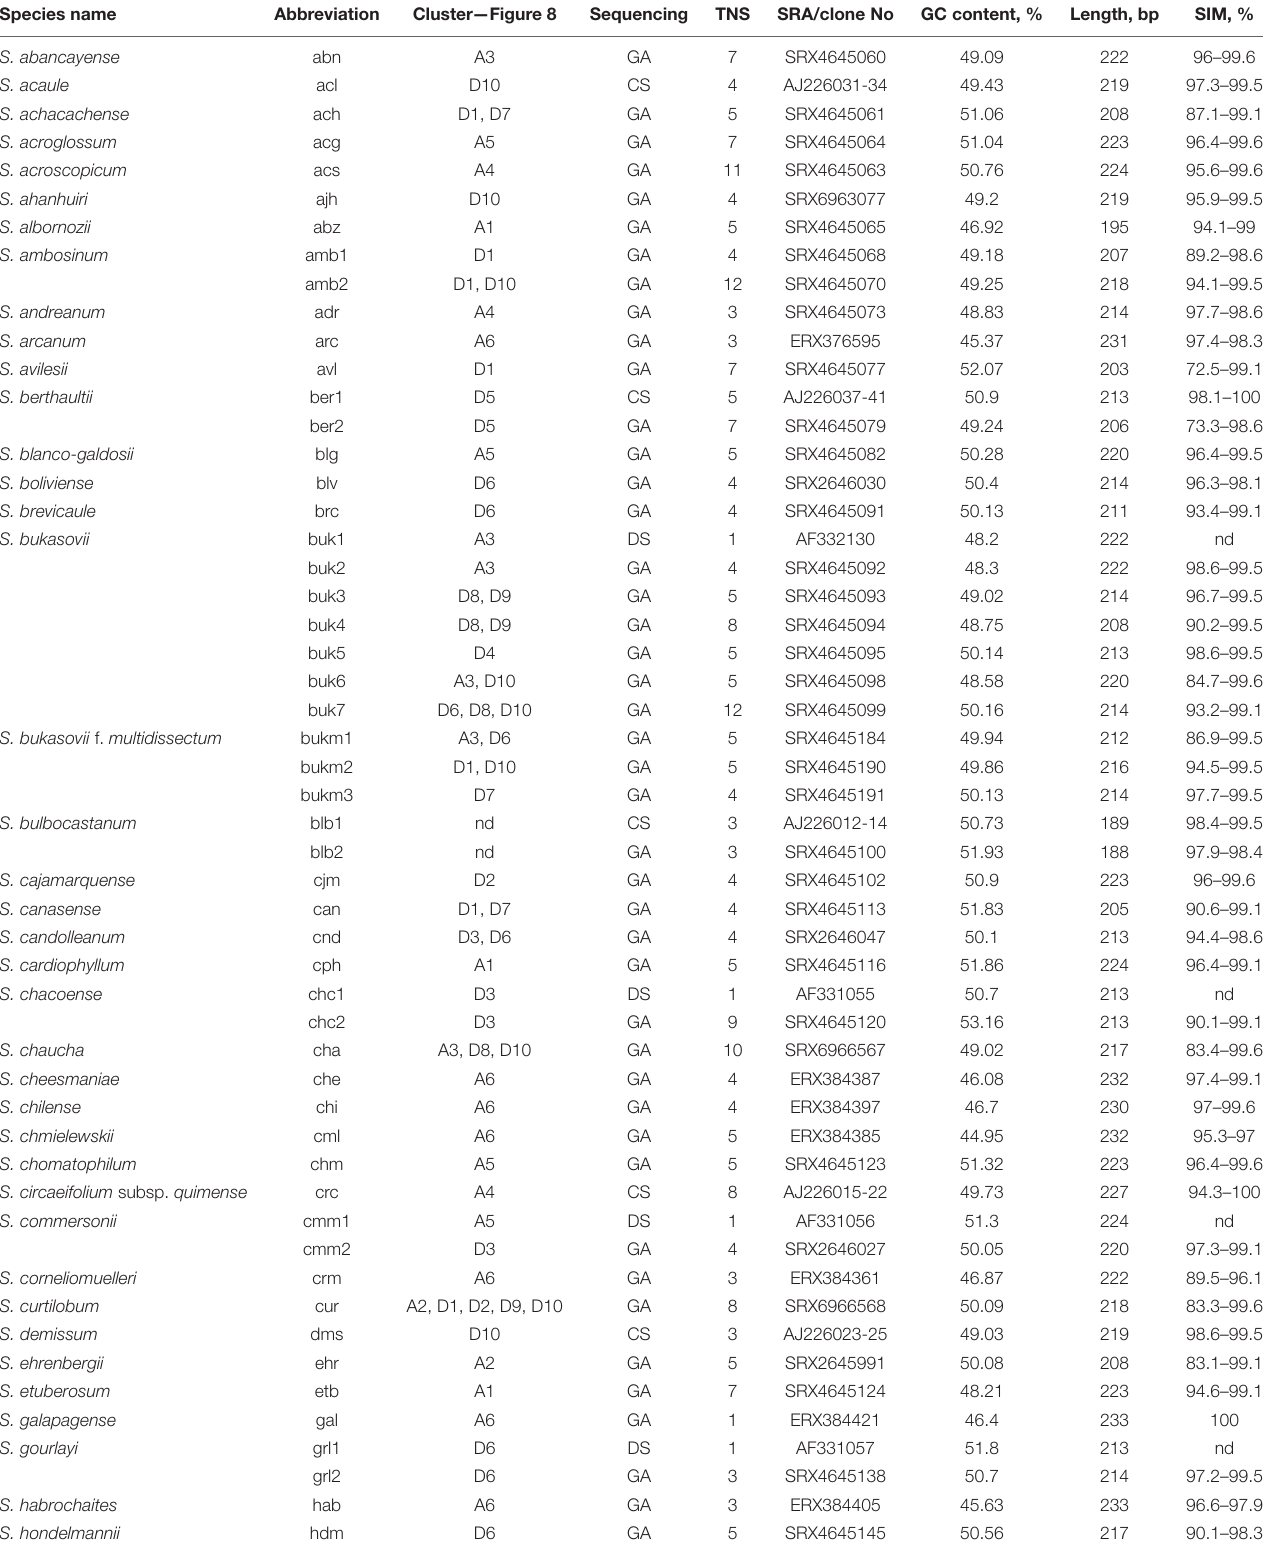
TABLE 4 | Characteristics of the 5S IGS of Solanum species of sect. Petota